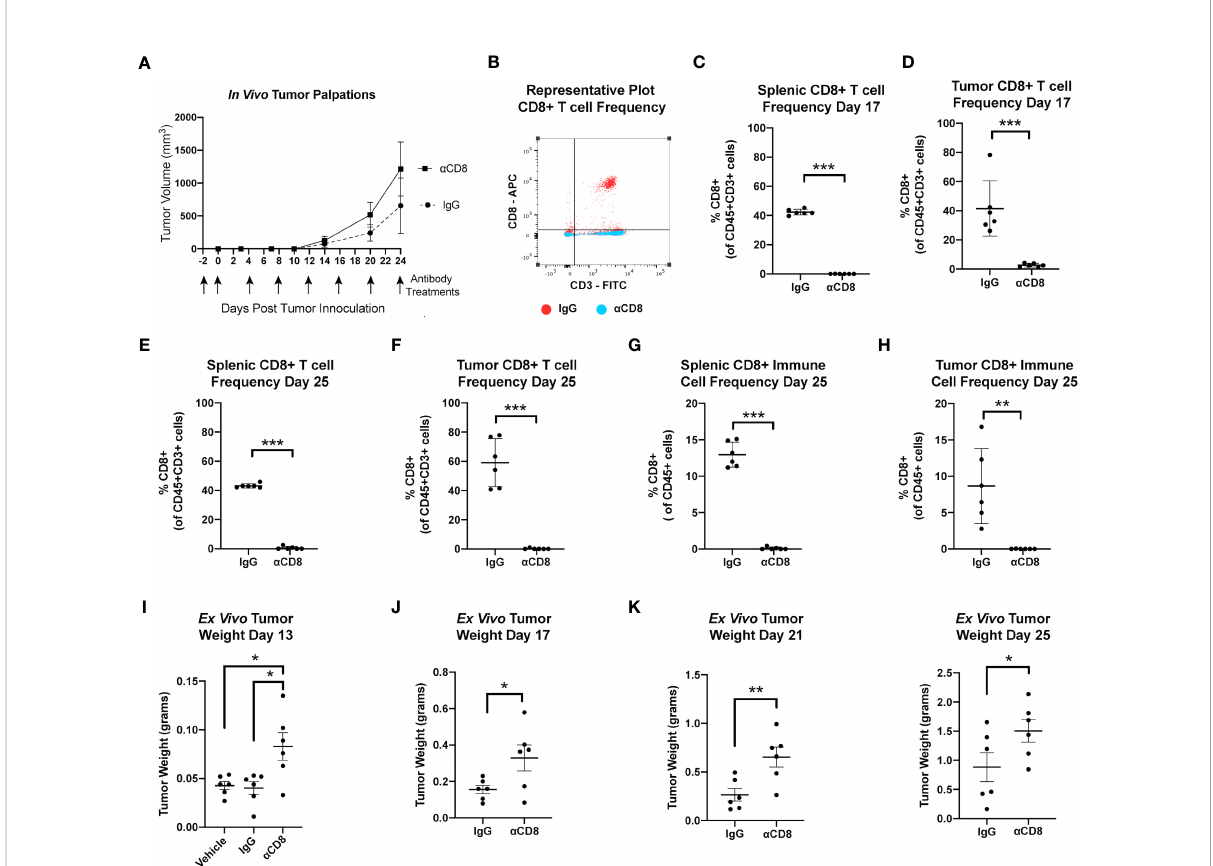
FIGURE 4 MetM-WNT lung tumor growth is constrained by CD8 T cell immune surveillance. (A) Study schematic and in vivo tumor volume. (B) Representative fl ow cytometry plot quantifying CD8+ T cells from IgG treated (red) and anti-CD8 antibody treated (blue) mice. (C-F) Flow cytometric analysis of splenic and tumoral CD45+CD3+CD8+ T cell populations at interim timepoint and study end point. (G, H) Flow cytometric analysis of splenic and tumoral CD45+CD8+ cells at study endpoint. (I-K) Ex vivo tumor mass measured days 13, 17, 21, and 25 following tumor injections. Data presented as mean ± SD. Differences across three groups analyzed using one-way ANOVA and Tukey post hoc test. Statistical differences across two groups determined by t test. Asterisks denote signi fi cance: *p< 0.05, **p< 0.01, ***p<